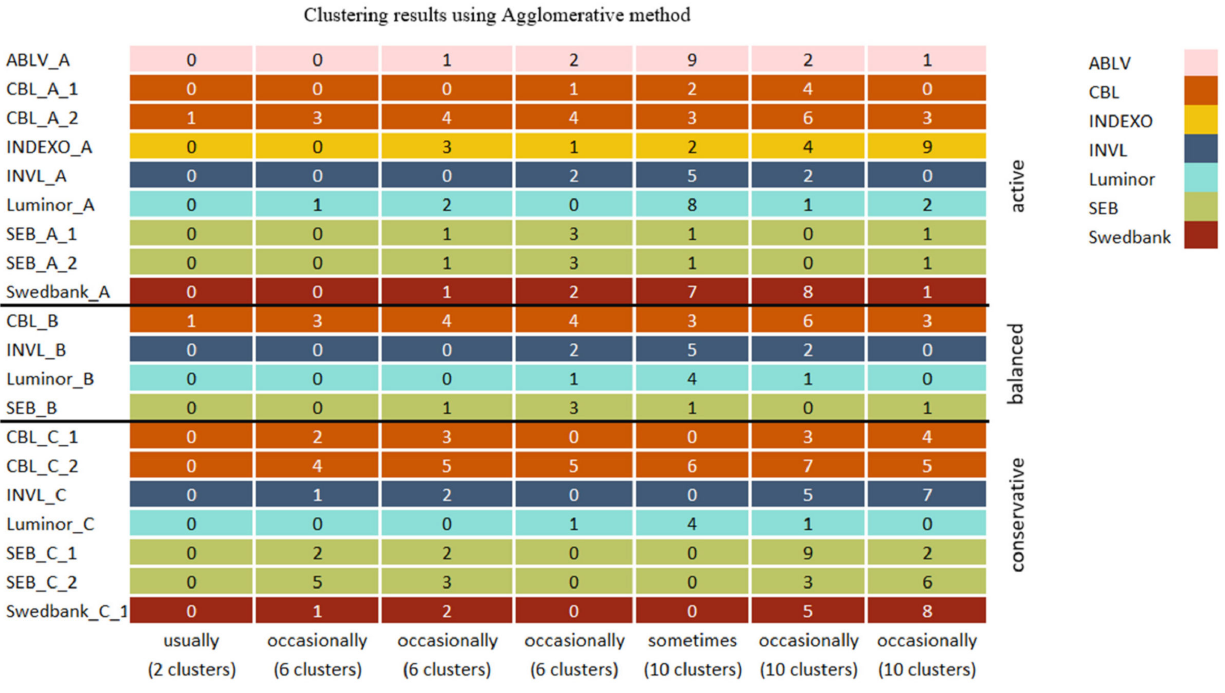
Figure 14. Agglomerative clustering algorithm results using a different number of clusters with the number of subgroups used noted in the parentheses.